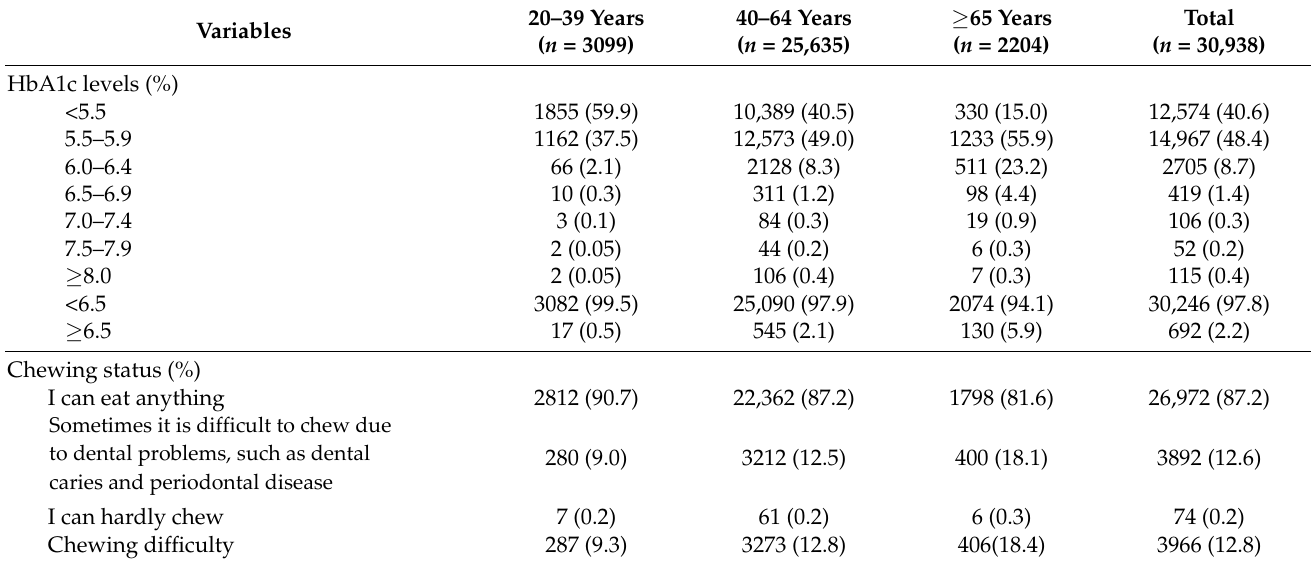
Table 1. Numbers of participants with different HbA1c levels and chewing status.